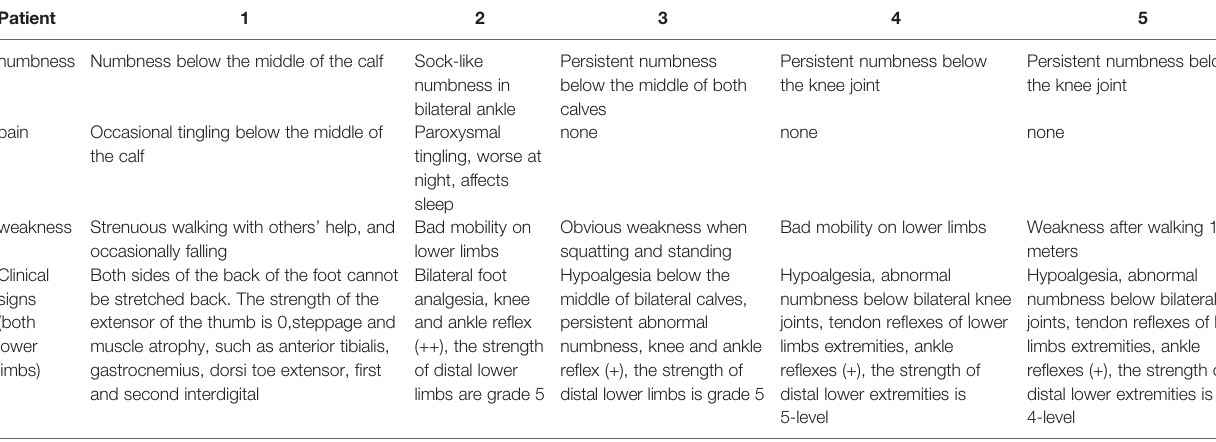
TABLE 1 | Clinical symptoms and signs of the fi ve patients. Patient